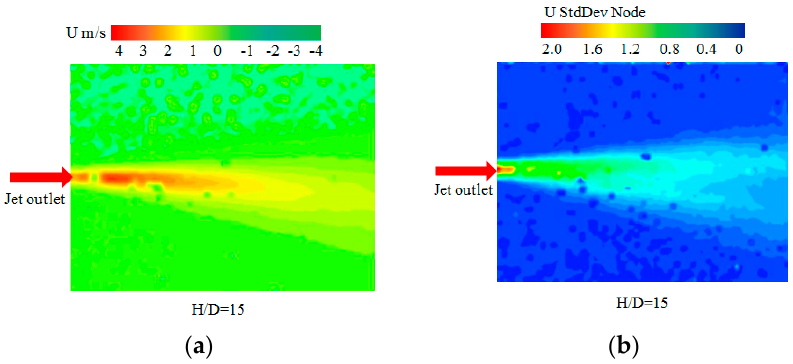
Figure 5. Cloud image of velocity: ( a ) Cloud image of average velocity; ( b ) Cloud image of fluctuation intensity.